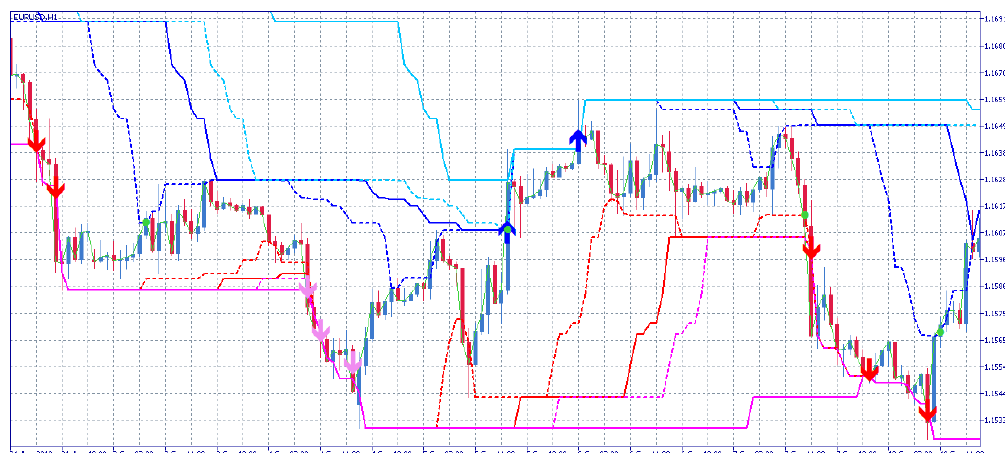
Figure A8. EUR/USD chart with signals from the AdPivot strategy